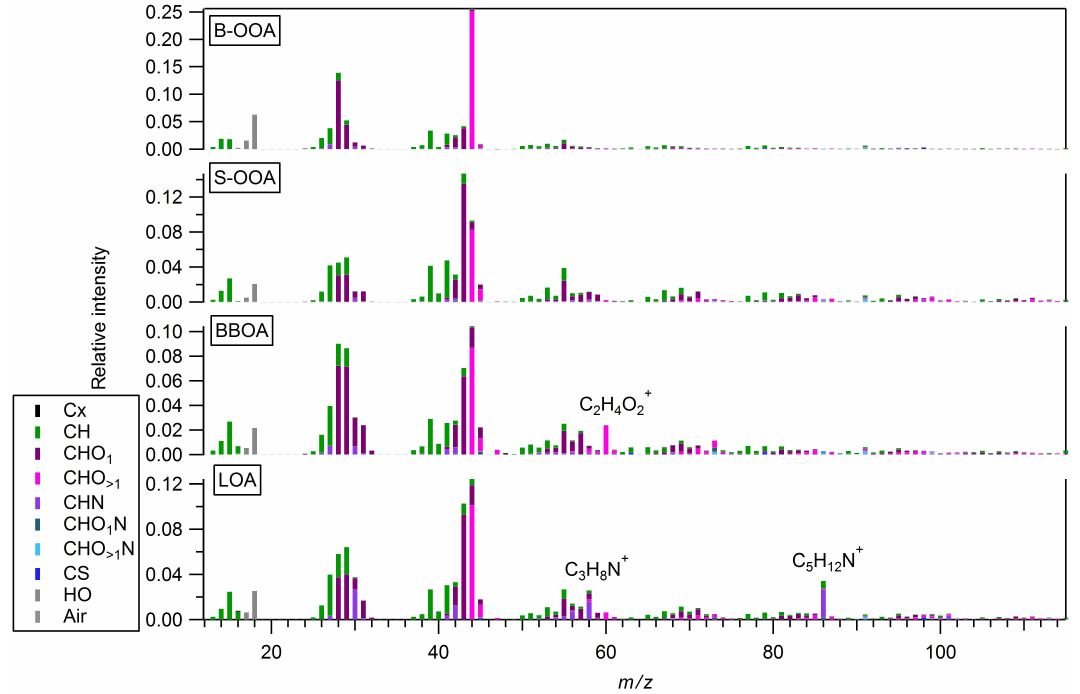
Figure 2. Offline-AMS PMF factor profiles: background oxygenated OA (B-OOA), summer oxygenated OA (S-OOA), biomass burning OA (BBOA), and local OA